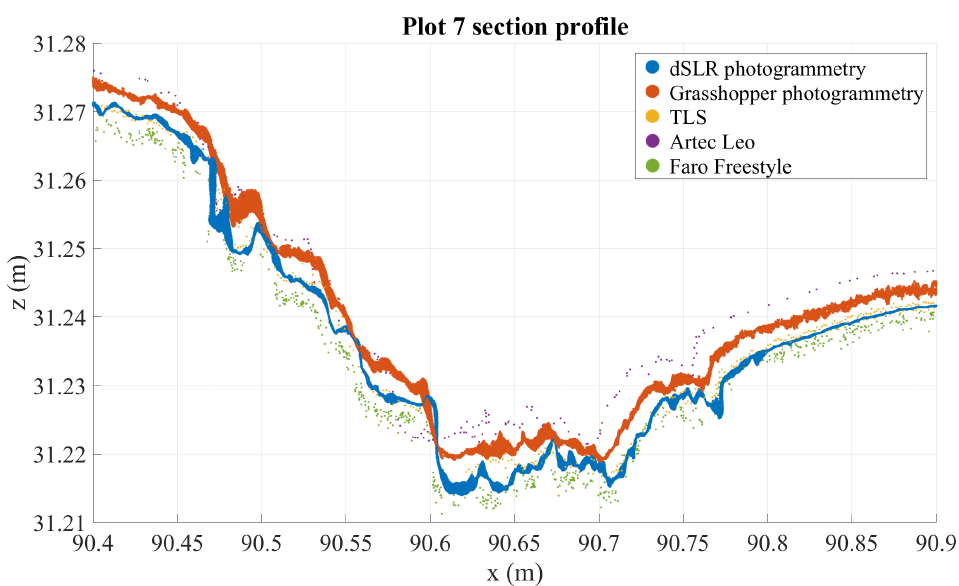
Figure 9. Three mm deep profiles of defect 27 as measured by all instruments in an arbitrary coordinate system.